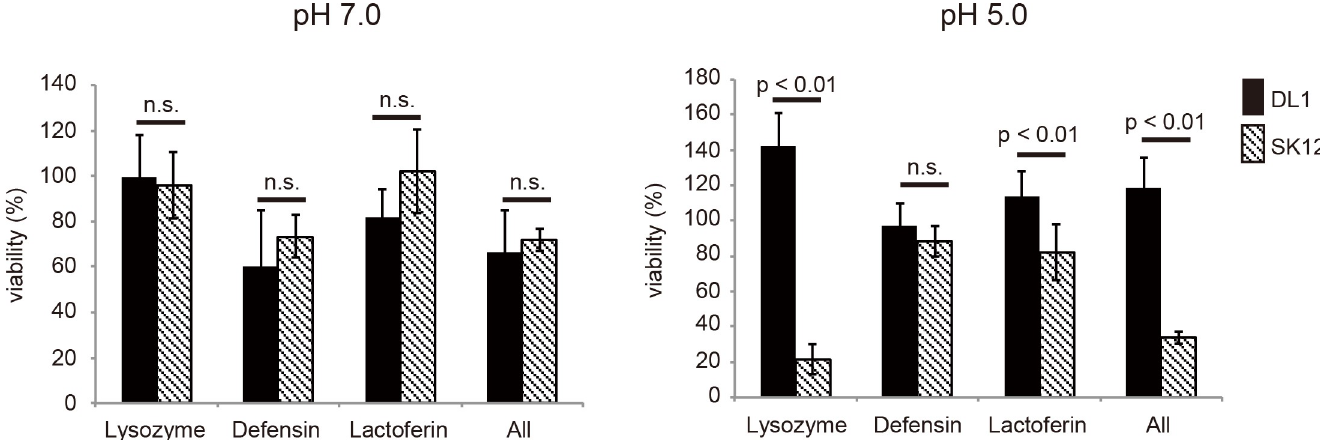
Fig 4. Survival of Streptococcus gordonii in bactericidal agent supplemented RPMI medium. Streptococcus gordonii DL1 and SK12 were cultivated in medium containing lysozyme (5 mg/ml), defensin (5 μ g/ml), Lactoferrin (10 μ g/ml), or a mixture of the three reagents for 2 h at 37˚C. Percent survival was calculated based on the number of viable cells in bactericidal agent-supplemented medium compared to that in medium without bactericidal agents. n = 4; mean with standard error is shown. Statistical differences in the means of obtained values were evaluated via unpaired t -test. n.s., not significant.